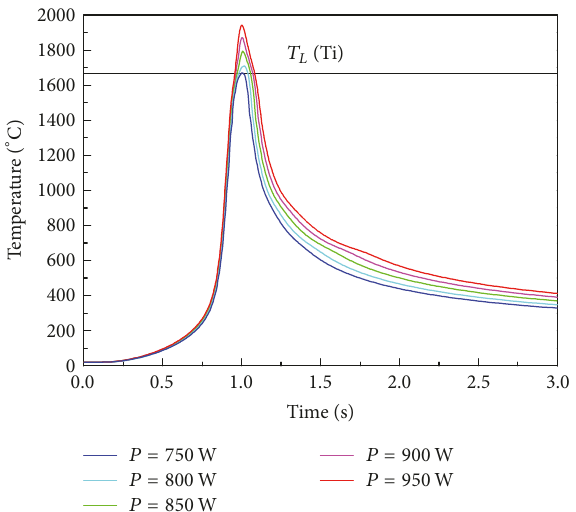
Figure 8: Time history of temperatures in the node 𝑃 located on the top surface in the centre of weld pool of Ti plate for different laser beam powers and the offset of 250 𝜇 m.